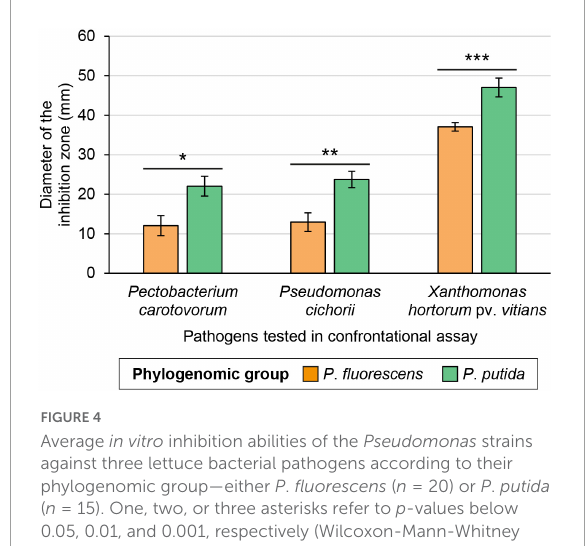
FIGURE4 Average in vitro inhibition abilities of the Pseudomonas strains against three lettuce bacterial pathogens according to their phylogenomic group—either P . fluorescens ( n = 20) or P . putida ( n = 15). One, two, or three asterisks refer to p -values below 0.05, 0.01, and 0.001, respectively (Wilcoxon-Mann-Whitney test). Error bars, standard